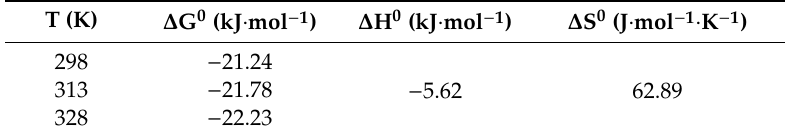
Table 5. Thermodynamic parameters of binary mixed